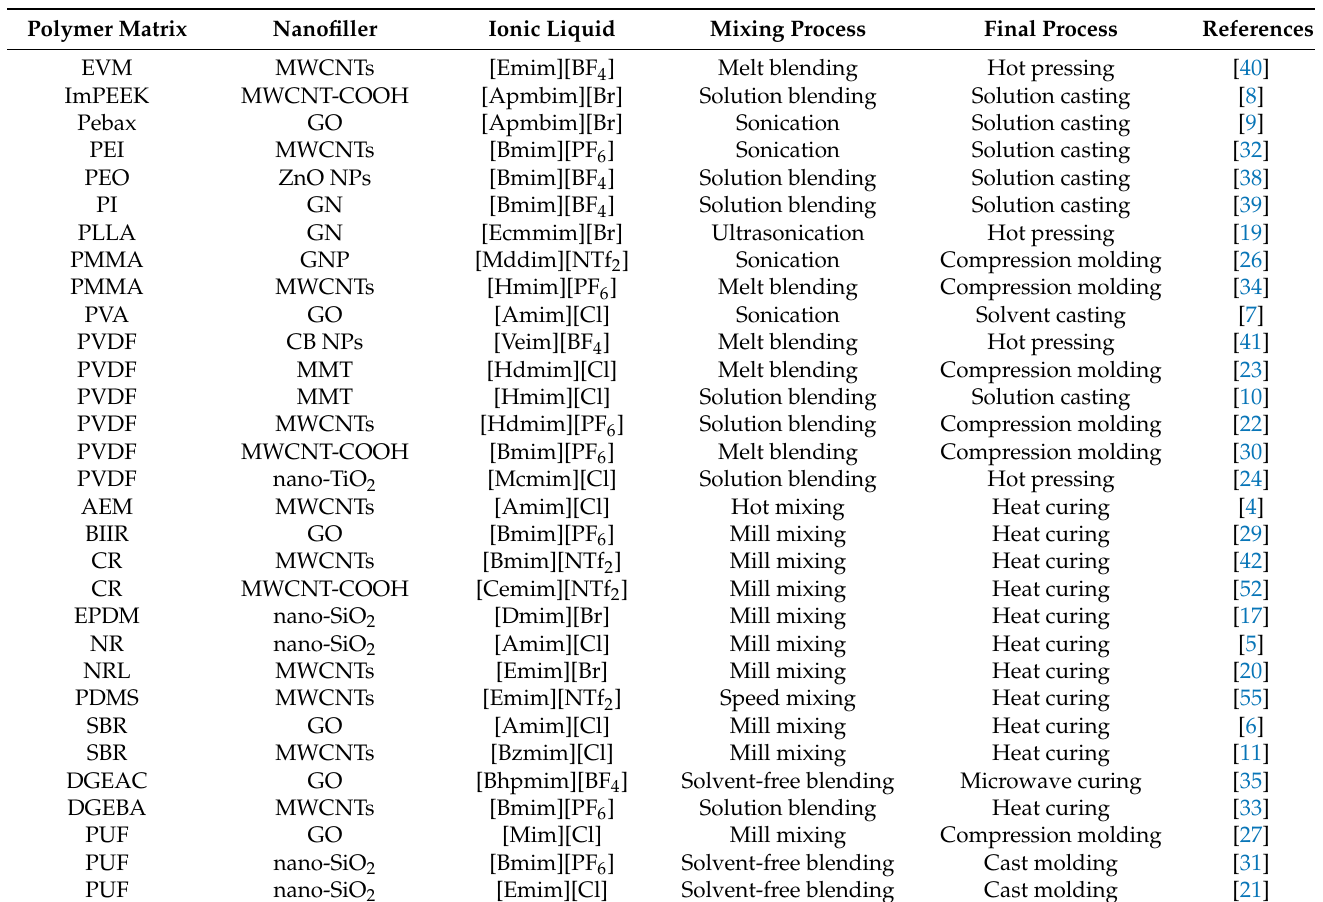
Table 4. Types of polymer matrices, nanofillers, ionic liquids, and fabrication processes of polymer nanocomposites. Polymer Matrix